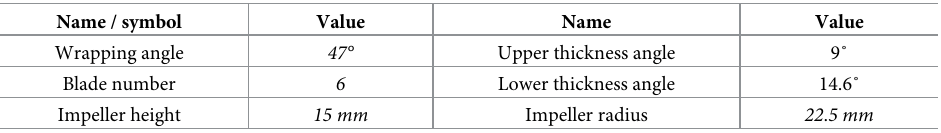
Table 2. Impeller parameters of original